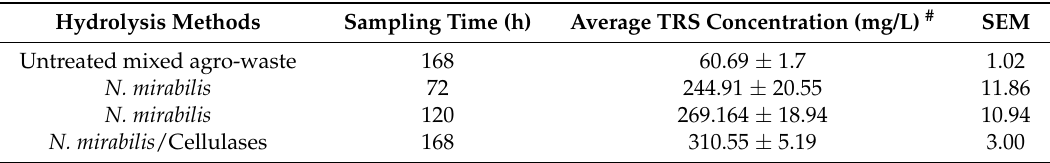
Table 6. Average total reducing sugars (TRS) concentration of N mirabilis digestive fluids hydrolysis of mixed agro-waste at 72, 120 and 168